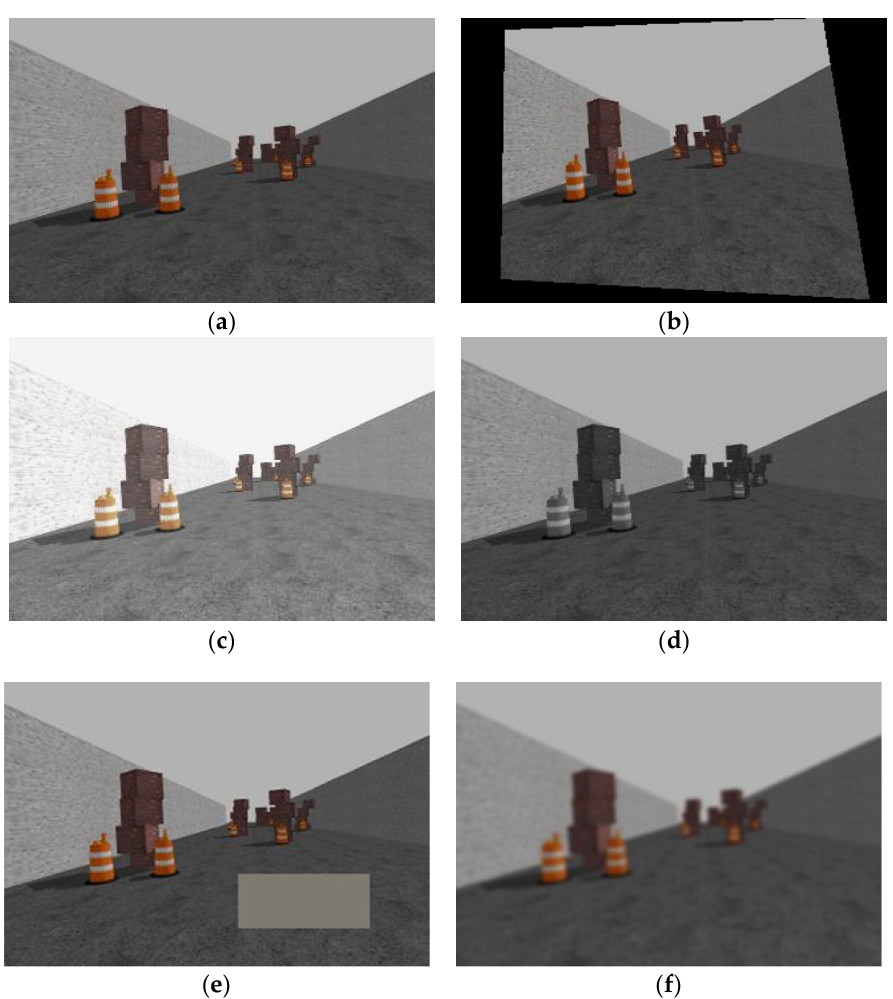
Figure 6. The data augmentation operators applied in the framework. Each augmenta tion trans- forms data stochastically with some random internal parameters. ( a ) Raw, ( b ) Random perspective, ( c ) Random color jitter, ( d ) Random grayscale, ( e ) Random cutout, ( f ) Random Gaussian blur. Table 2. Parameter Setting for the